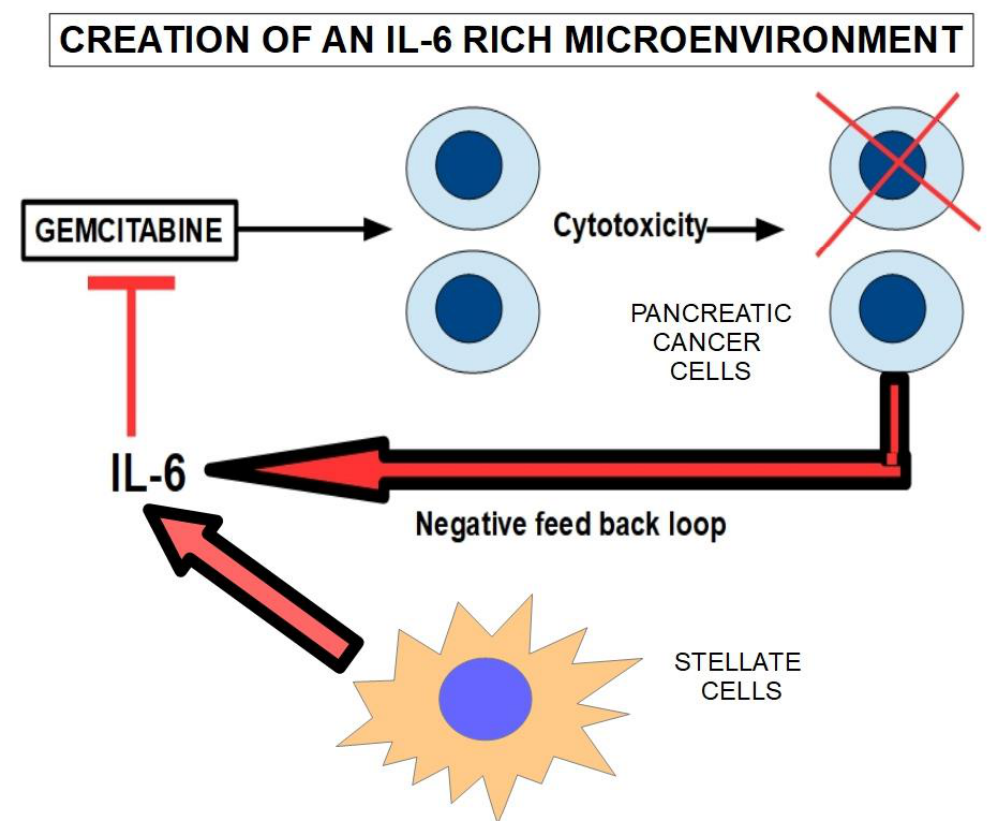
Figure 13. Gemcitabine increases IL-6 expression in the surviving malignant cells, which in turn inhibits gemcitabine ’ s cytotoxicity through the production/secretion of IL-6. Tocilizumab is a monoclonal antibody directed against the IL-6 axis. It has been shown that tocilizumab prevents STAT 3 activation in pancreatic cancer [519]. A clinical trial (NCT02866383) is underway to determine if adding tocilizumab to gemcitabine